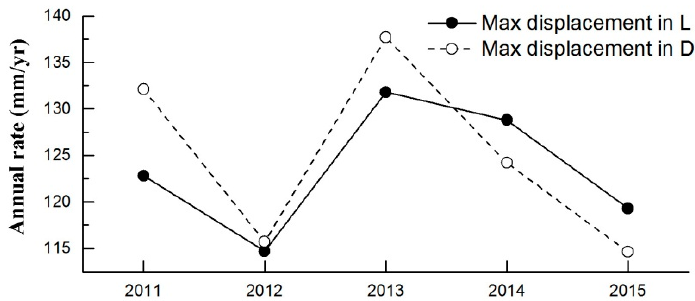
Figure 6. Time series of the land displacement in the study area. L indicates the Laiguangying land subsidence area, and D indicates the DongbalizhuangDajiaoting land subsidence area.